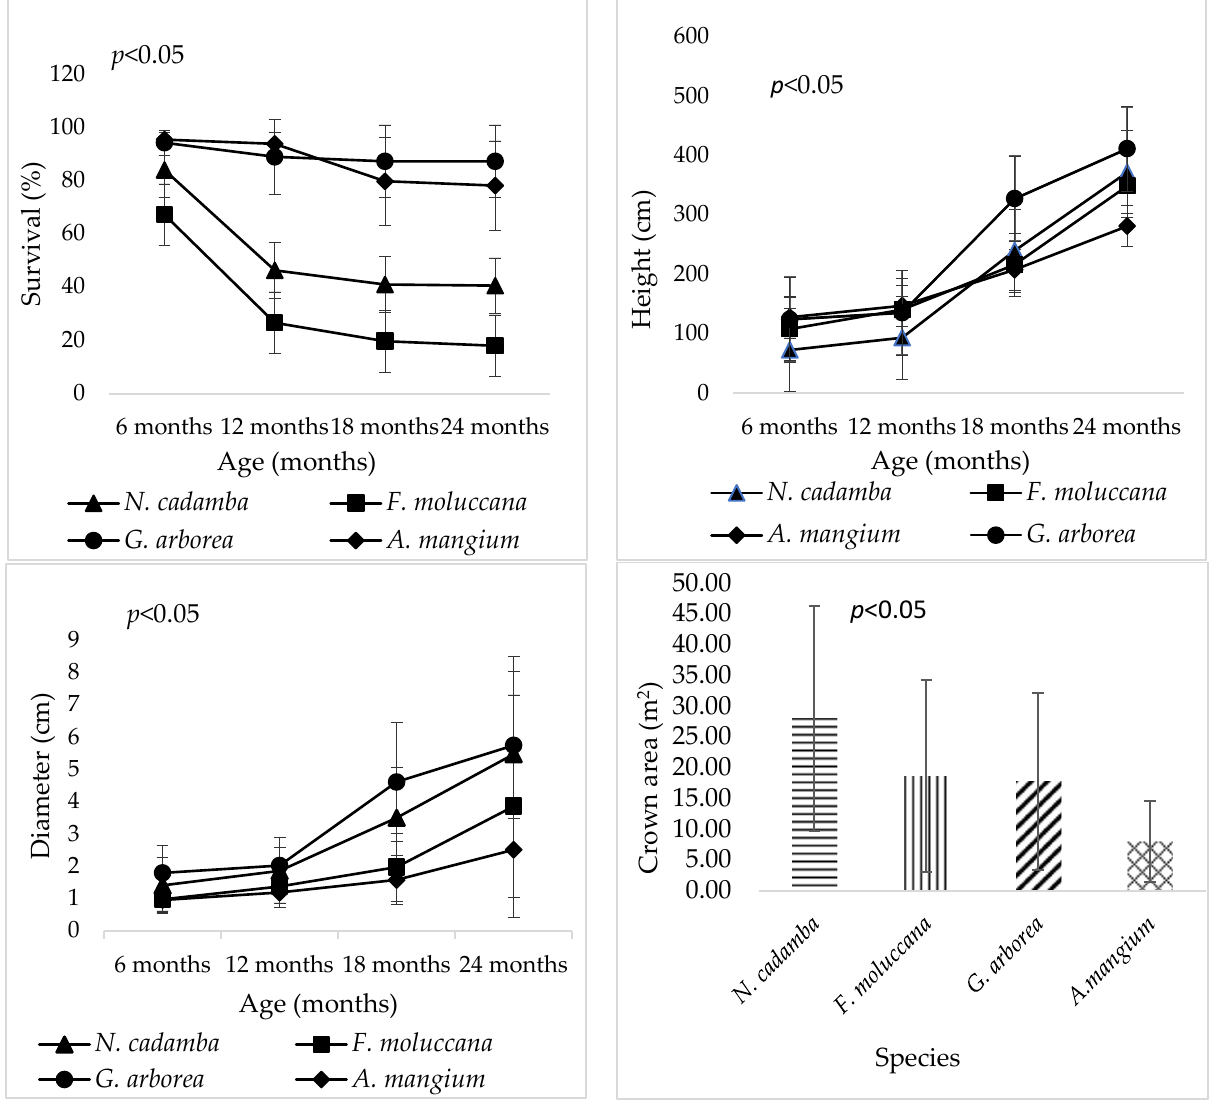
Figure 3. The survival rate and the growth of four fast growing tree species 24 MAP in rocky soil of community forest, Gunungkidul, Yogyakarta (data = mean ± SD, block = 5).